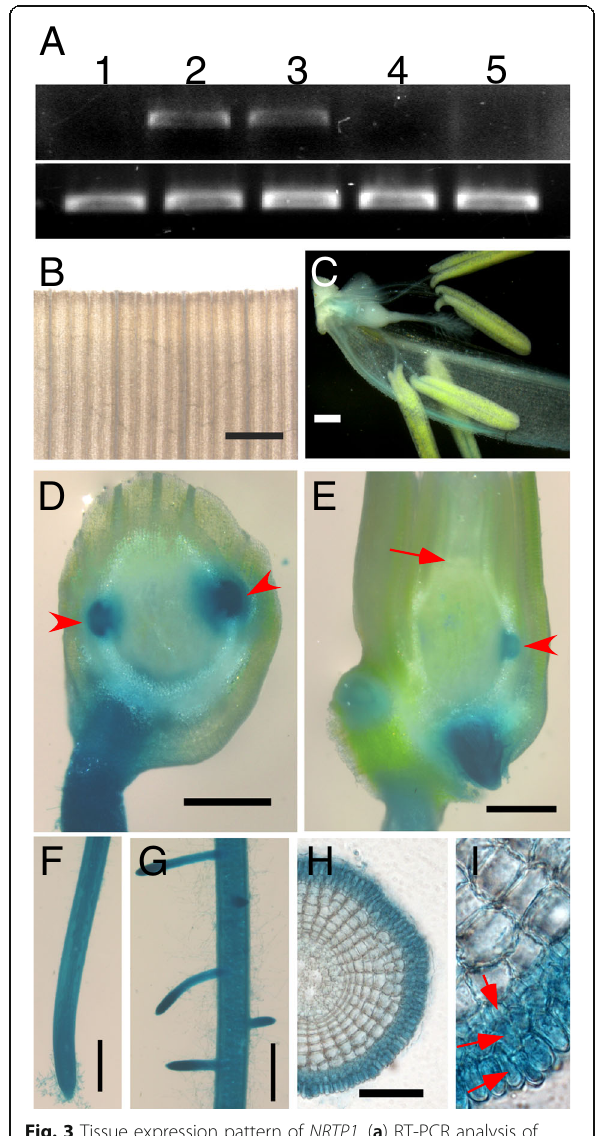
Fig. 3 Tissue expression pattern of NRTP1 . ( a ) RT-PCR analysis of NRTP1 expression in different tissues. 1, shoot; 2, root; 3, stem base. 1, 2 and 3 are from 7-d-old seedlings. 4, stem; 5, young panicle. 4 and 5 are from mature plants. ( b - i ) GUS staining of NRTP1p - GUS transgenic plants. ( b ) Leaf; ( c ) Flower; ( d ) Transverse section of stem base. Arrow heads indicate crown root primordia; ( e ) Longitudinal section of stem base. Arrow indicates shoot apical meristem, arrow head indicates crown root primordia; ( f and g ) Root; ( h ) Transverse section of root; ( i ) Magnification of ( h ), arrows indicate three outermost cell layers stained by GUS. ( b - c ) mature plants, ( d - i ) 7-d-old seedlings. Bars = 500 μ m in ( b - g ), bar = 100 μ m in ( h